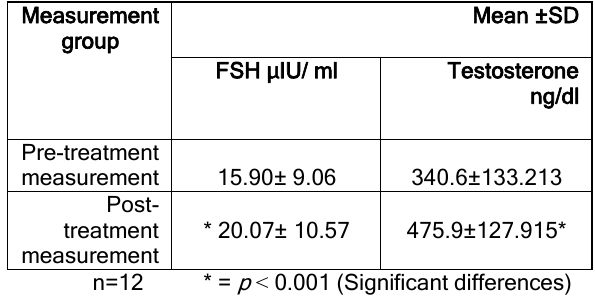
Table 2: The pre-post treatment values of serum zinc & semen zinc levels .